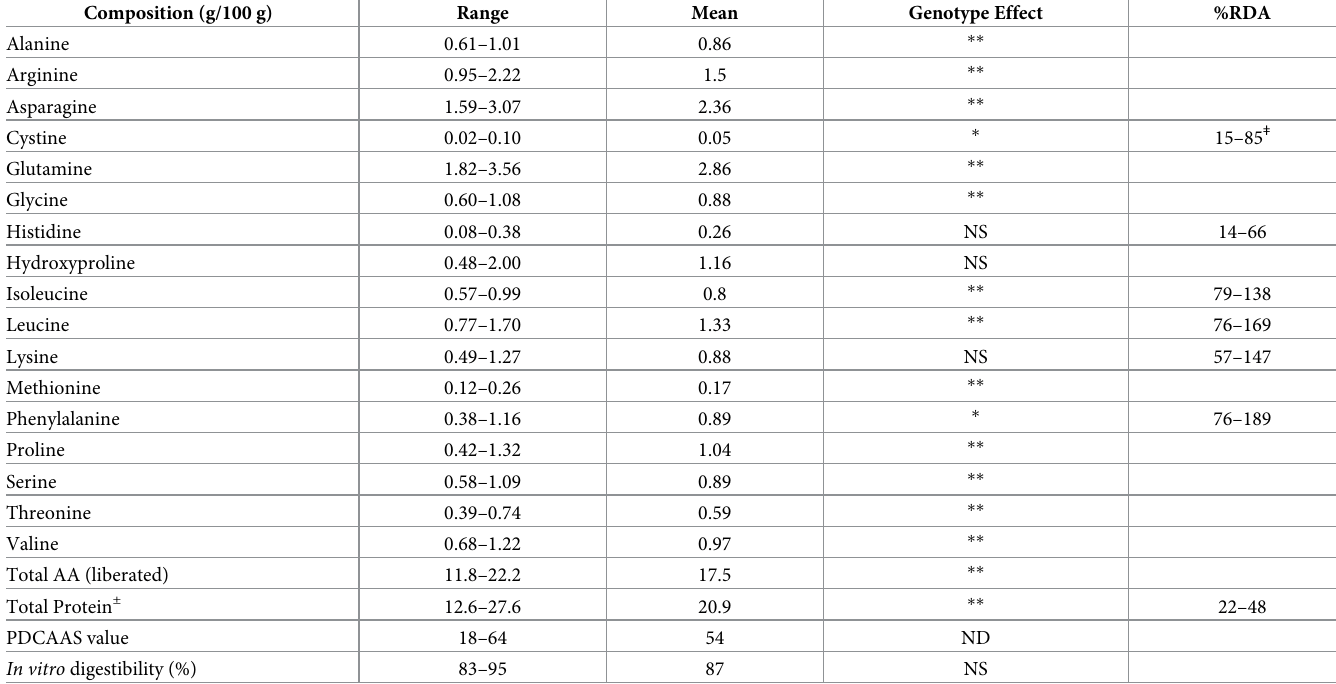
Table 2. Range and mean amino acid concentrations of organic dry pea grown in